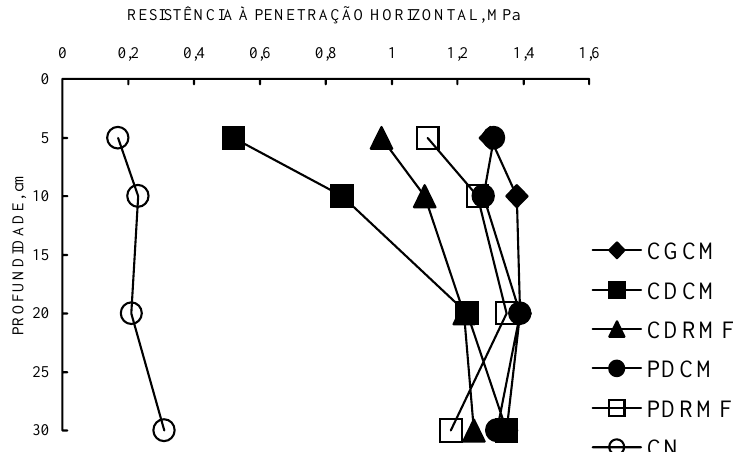
Figura 1. Resistência à penetração horizontal em Latossolo Vermelho distrófico típico, em diferentes profundidades, sistemas de manejo e cerrado nativo, Sete Lagoas